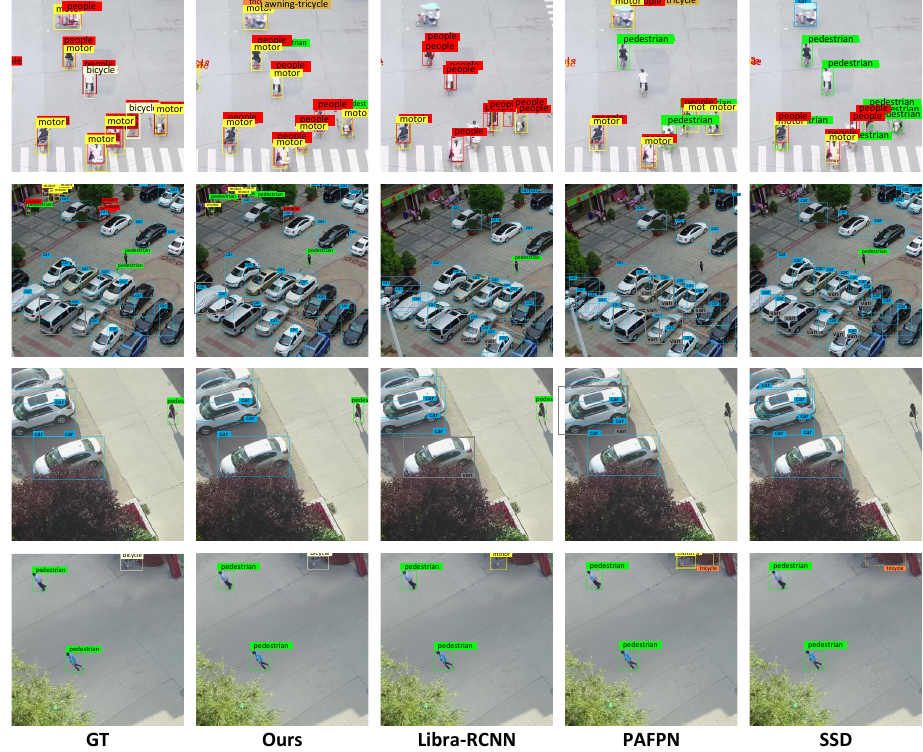
Ours Figure 11. Visual comparison. From left to right are ground-truth, our results, Libra-RCNN, PAFPN, and